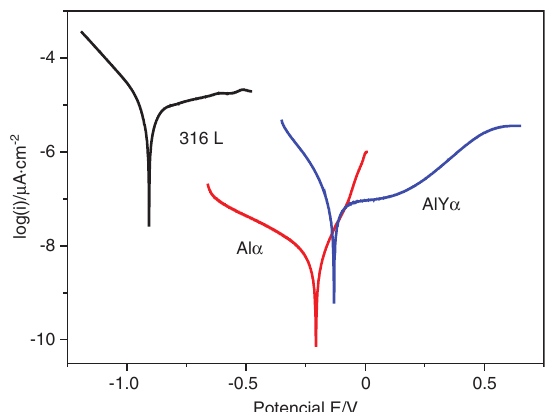
Figure 5: Polarization curves for plasma oxide coating and 316L stainless steel in 3.5% NaCl solution.